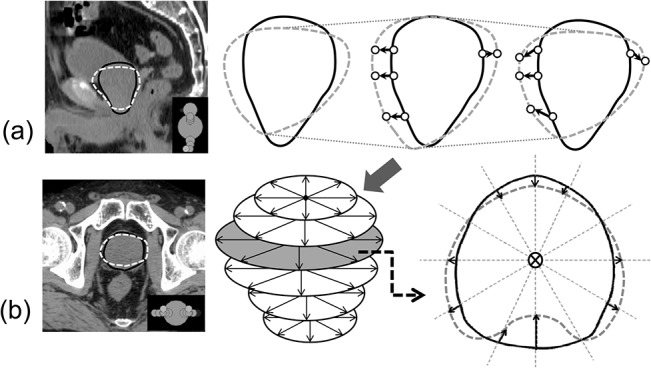
Definition of the proposed prostate deformation quantification metric.The solid and dashed lines represent the prostate contours in the planning CT and CBCT scans, respectively. (a) A 2D representation of the sagittal contours of the prostate. To align the positions of the base and apex of prostate contours in the CBCT scans to those in the planning CT scan, craniocaudal views of the prostate contour in the CBCT scans were either expanded or contracted. They were returned to their original states after the alignment. (b) A 2D representation of the axial contours of a prostate. The cross mark is the CoG of the prostate in a representative slice. The arrows indicate the prostate deformation directions.